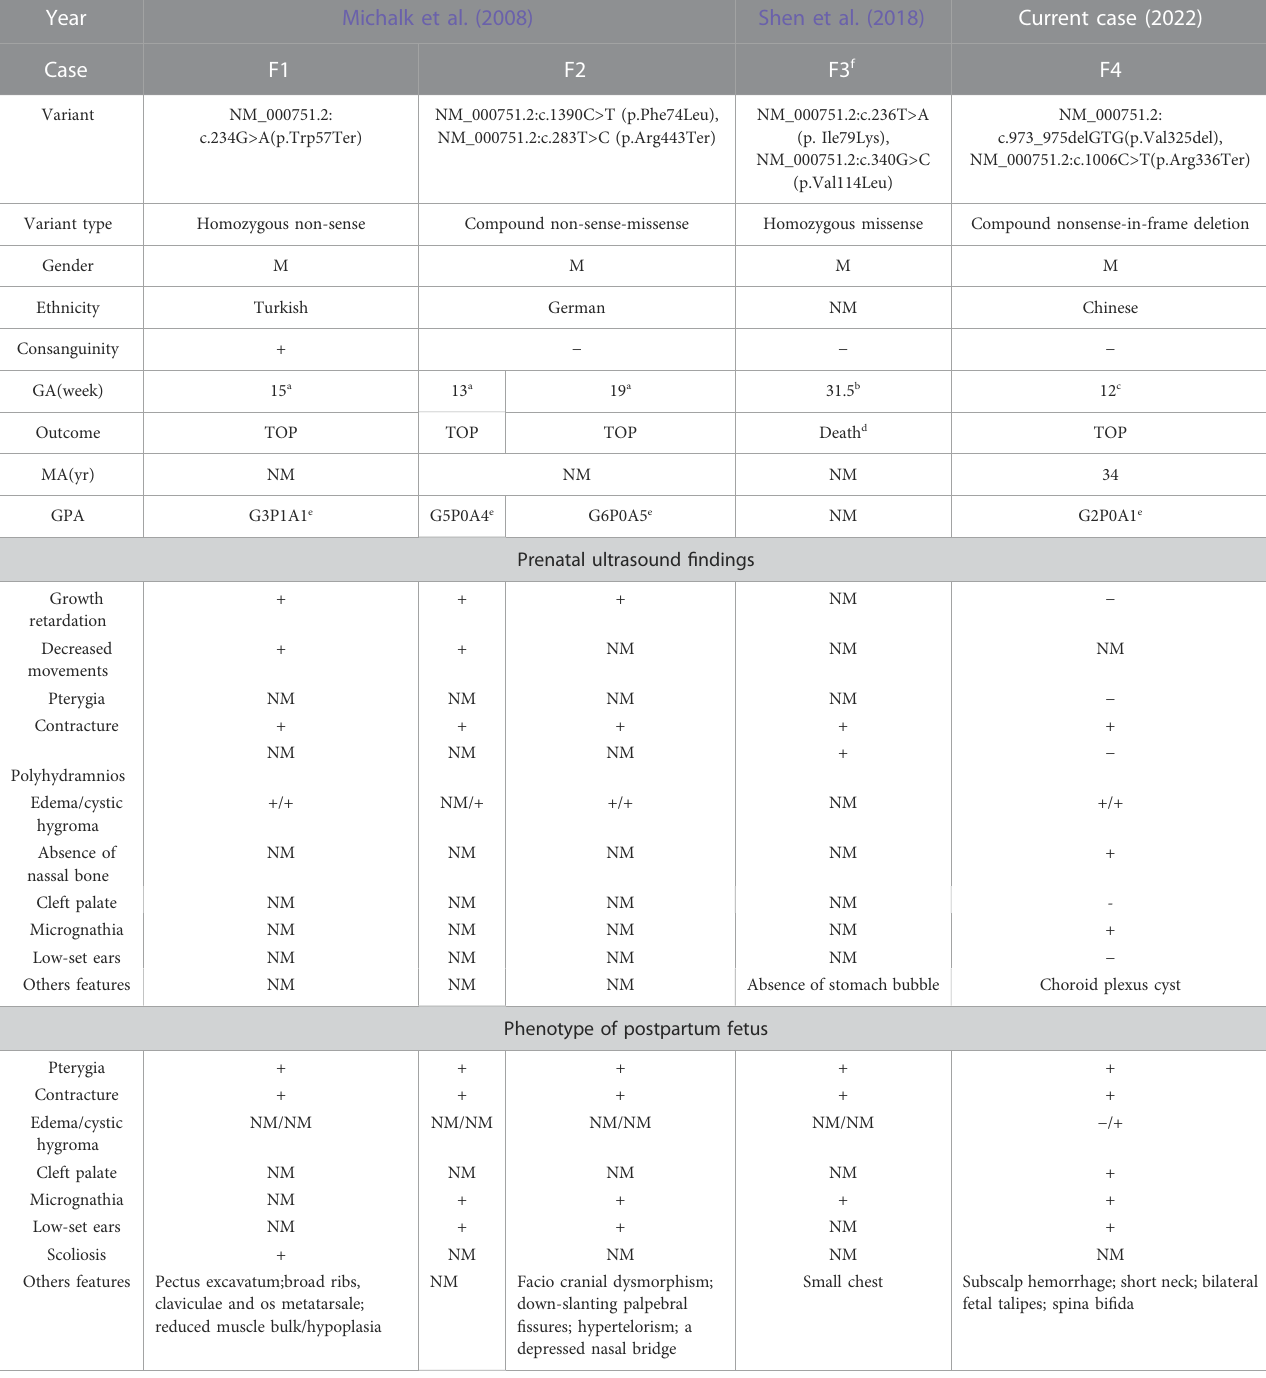
TABLE 1 Summary of clinical manifestations in the current patients with CHRND gene